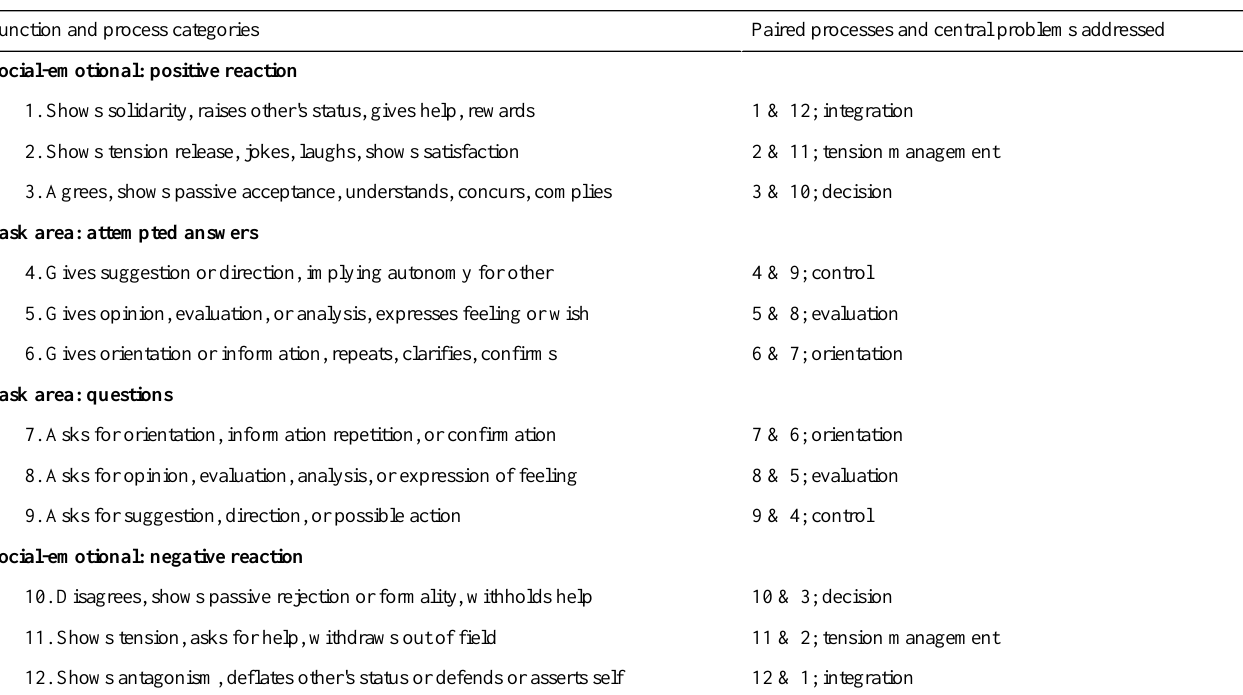
Table 1. System of process categories in the interaction process